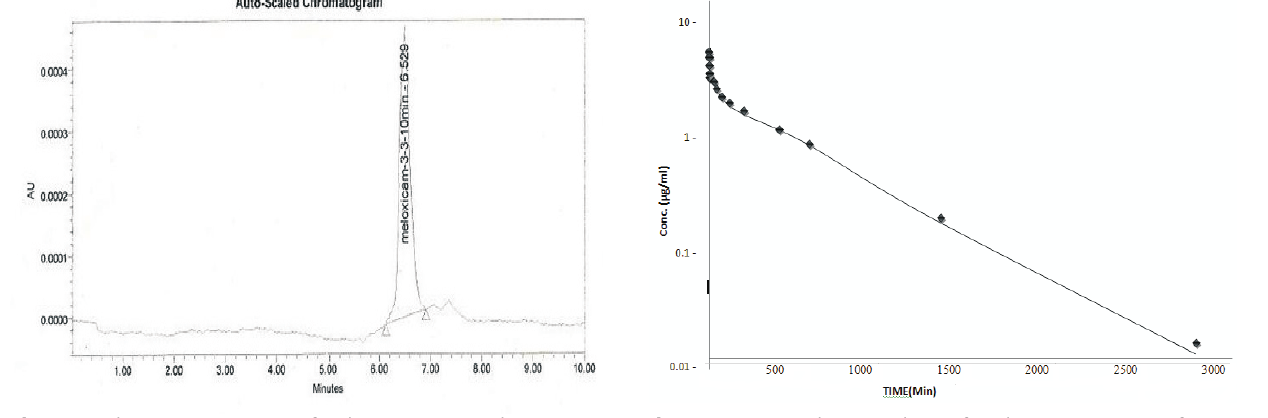
Figure-2. Mean plasma values of Meloxicam in goat after iv administration at the dose of 1mg/kg.